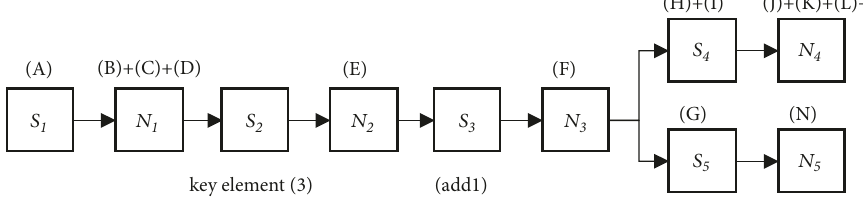
Figure 3: Reconstructed workflow model for the emergency response process.